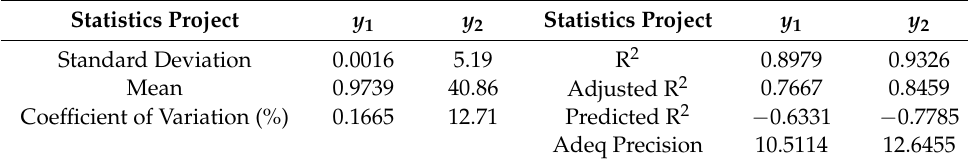
Table 4. Error Statistics Analysis Results of Regression